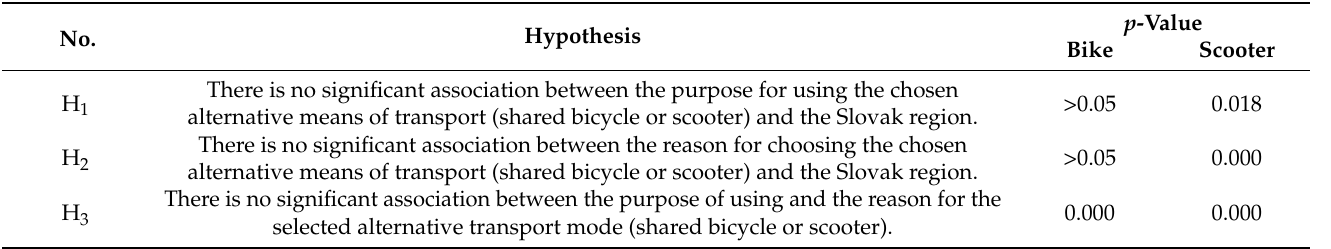
Table 5. Pearson chi-square